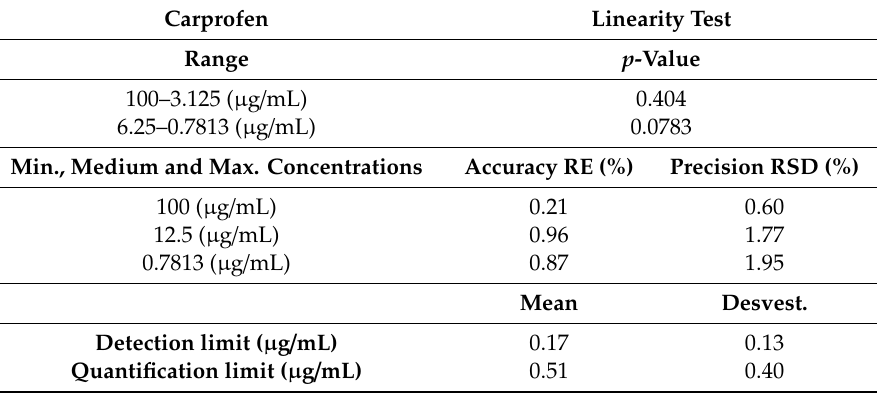
Table 1. Linearity test of the concentration range of both curves, accuracy and precision of minimum, medium and maximum concentration value and detection and quantification limits of the chromatographic quantification of